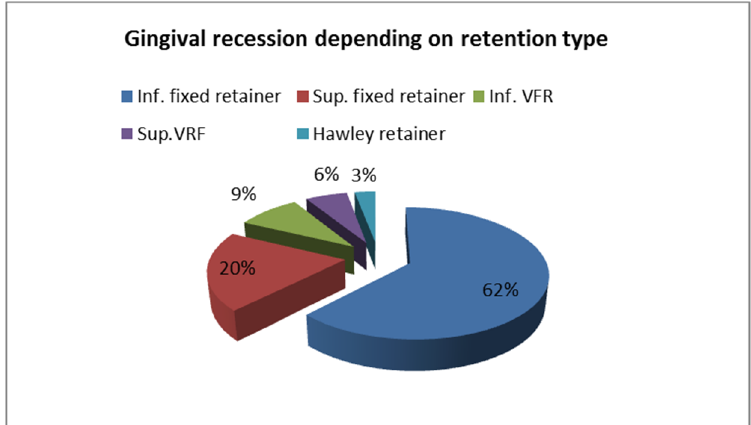
Figure 7. Gingival recession, male group.